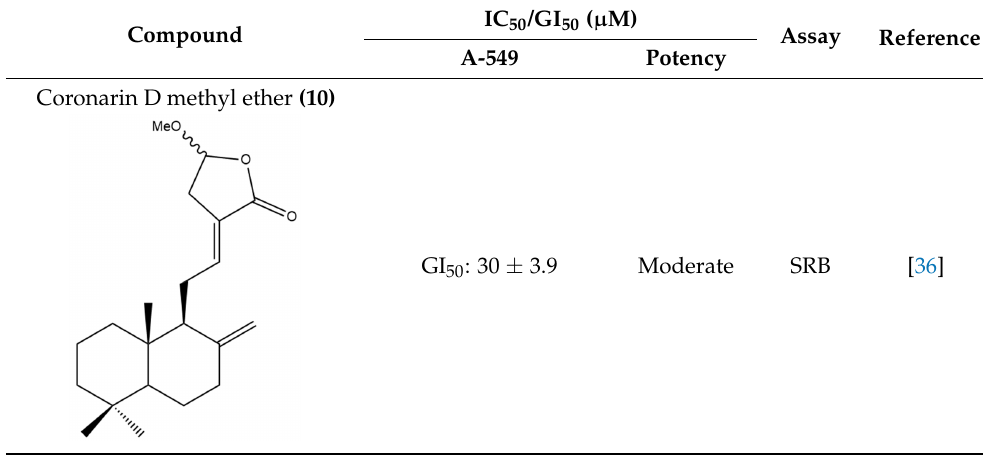
Table 18. Cytotoxic activities of labdane-type diterpenes from the Zingiberaceae against A-549 lung cancer cell